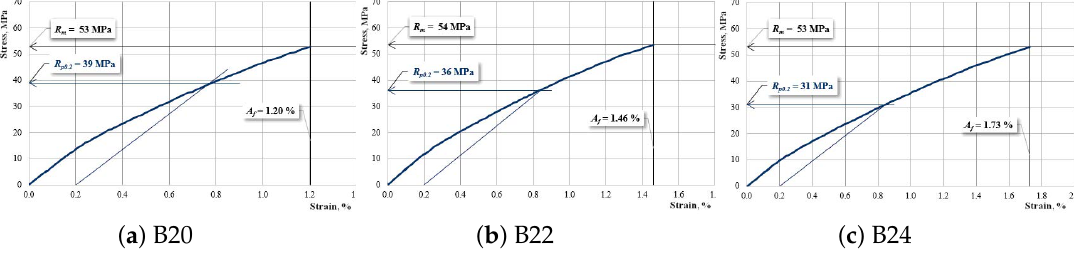
Figure 10. The characteristic curve for a sample: ( a ) B20; ( b ) B22; ( c ) B24.